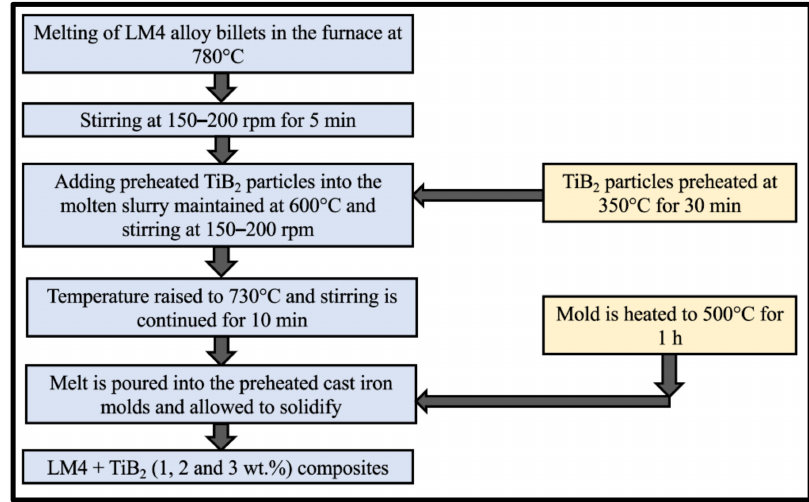
Figure 3. Flow chart for the fabrication of LM4 + TiB 2 composites.